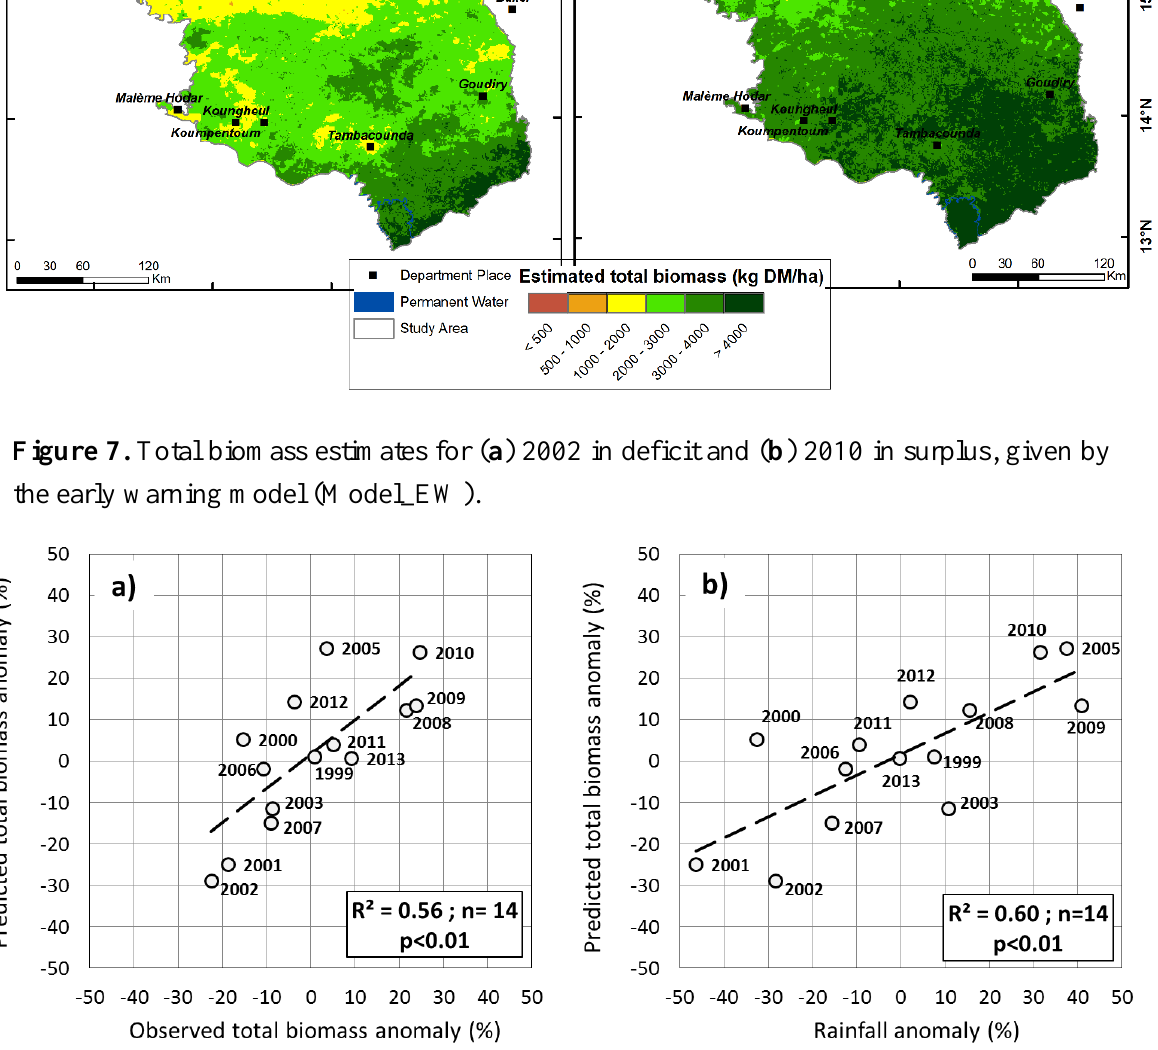
Figure 8. Scatterplots of anomalies of total biomass predicted by the early warning model, with ( a ) observed total biomass and ( b ) rainfall from 1999 to